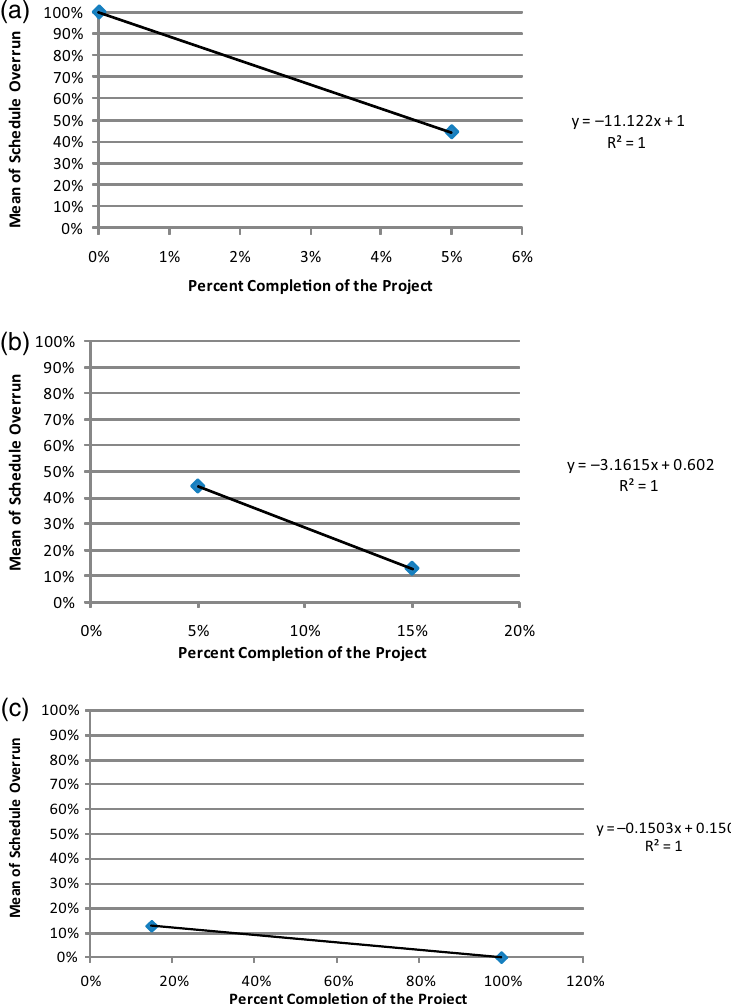
Fig. 2. Overview of contingency available in PE/FEIS phase (a); Overview of contingency remaining in FD phase (b); Overview of contingency remaining in Construction phase (c)